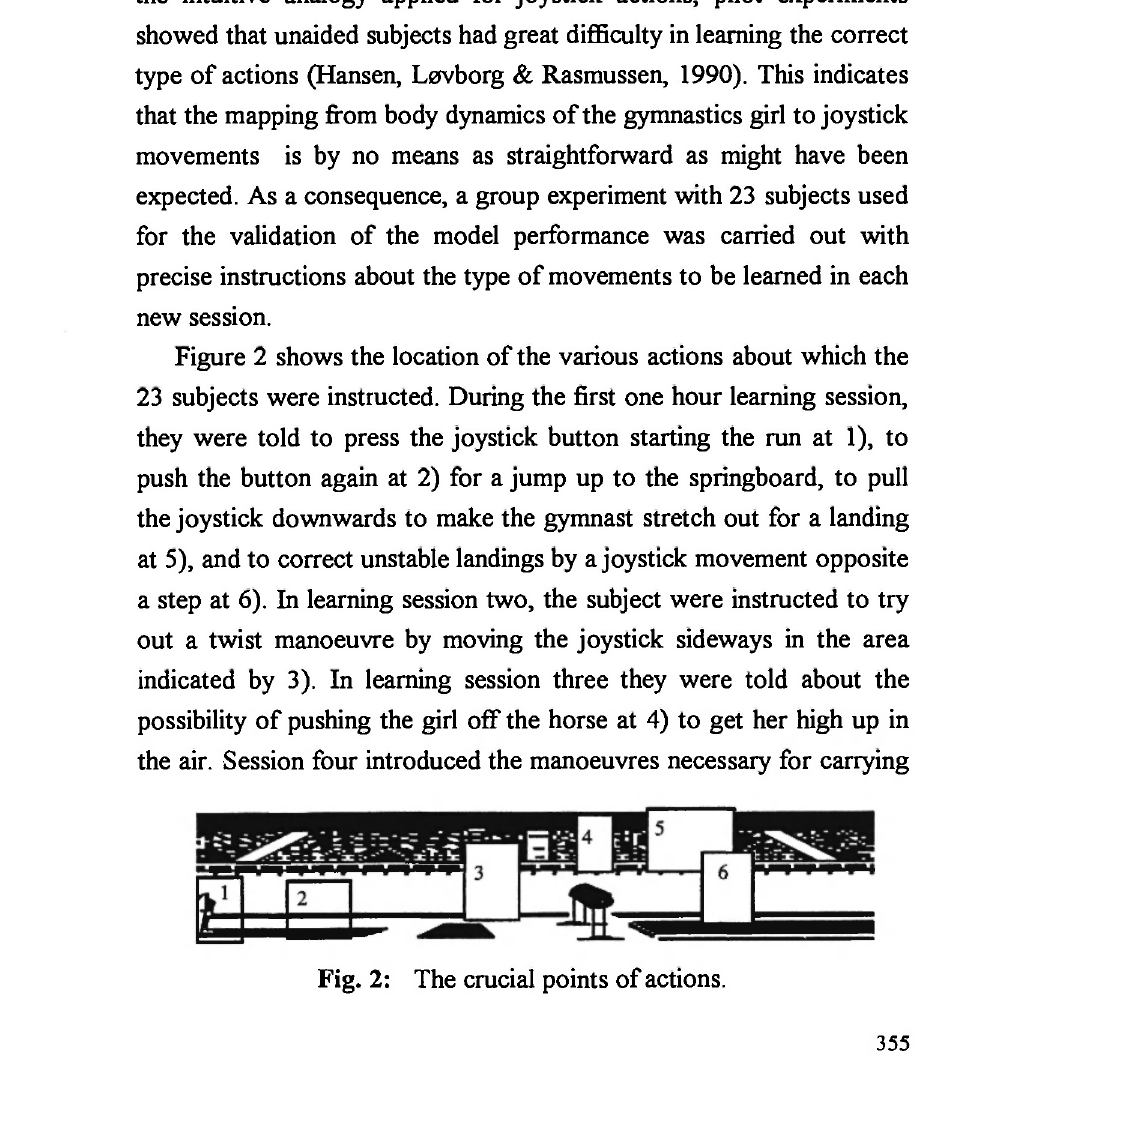
Fig. 2: The crucial points of